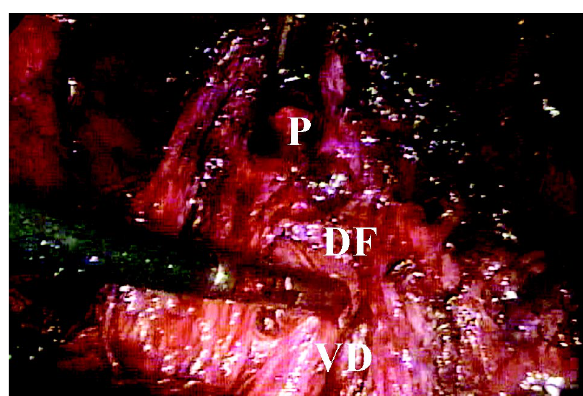
Figure 8 – Sectioning of bladder neck with harmonic scalpel preserving muscular fibers. As a result, we obtained a small di- ameter neck (dotted line), which makes future vesicourethral anas- tomosis easier. BN = bladder neck, SM = muscle fibers.